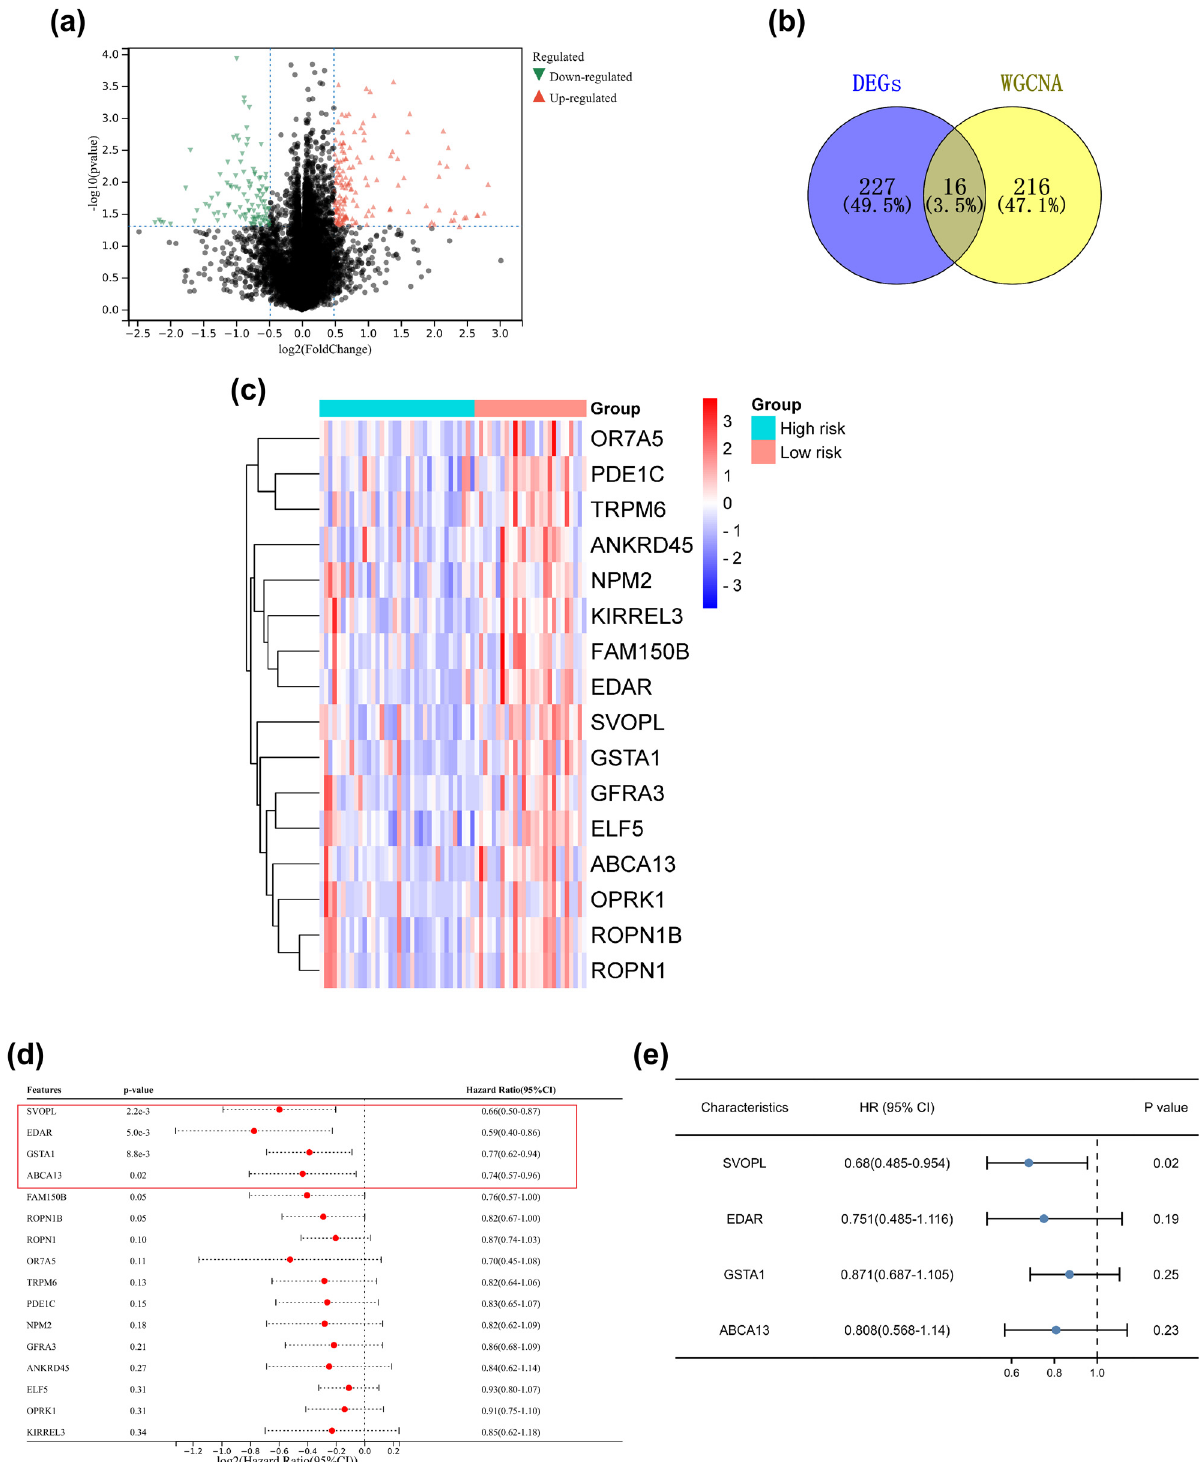
Figure 2: Identi fi cation of chemoradiotherapy resistance - related genes in breast cancer. ( a ) The volcano diagram of DEGs. ( b ) Identi fi cation of hub genes in co - expression network and DEG network. ( c ) The heat map of 16 hub genes expression between low - risk and high - risk groups. The survival of breast cancer patients was performed by ( d ) univariate and ( e ) multivariate cox regression